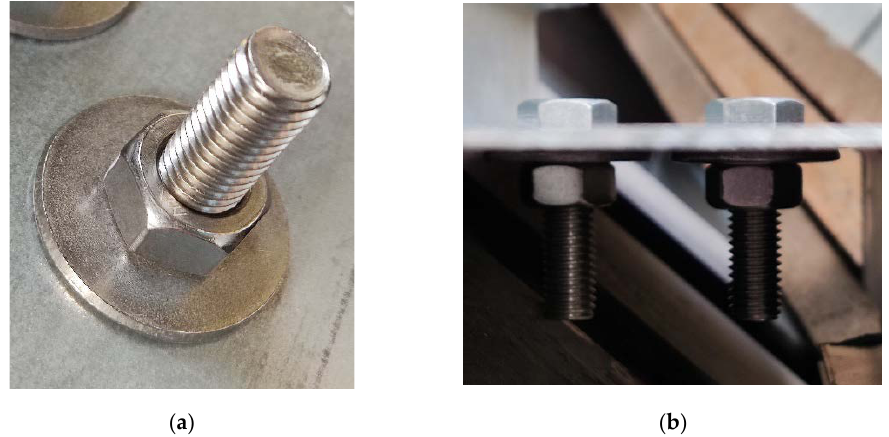
Figure 2. Pictures of the M12 bolt with hexagonal nut connectors: ( a ) view of the nut from the bottom of the joint and ( b ) side view (source: grant POIR.01.01.01-00-0177/21).